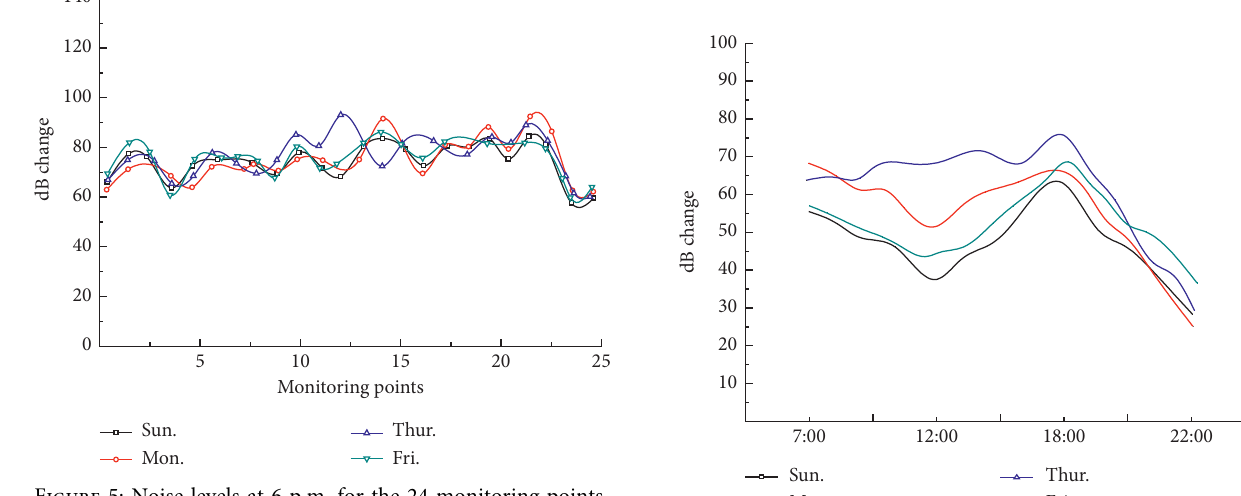
Figure 6: Noise levels recorded at 10 p.m. for the 24 monitoring points, with fluctuations corresponding to the passing of the light rail.